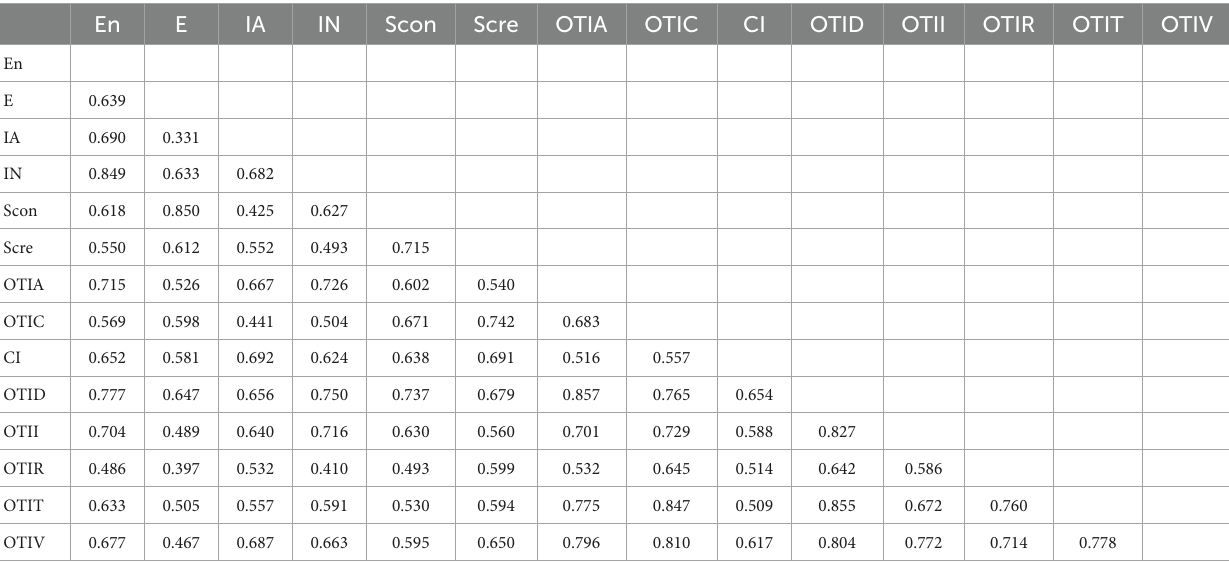
TABLE 4 Heterogeneity-Monogeneity (HTMT) ratio.